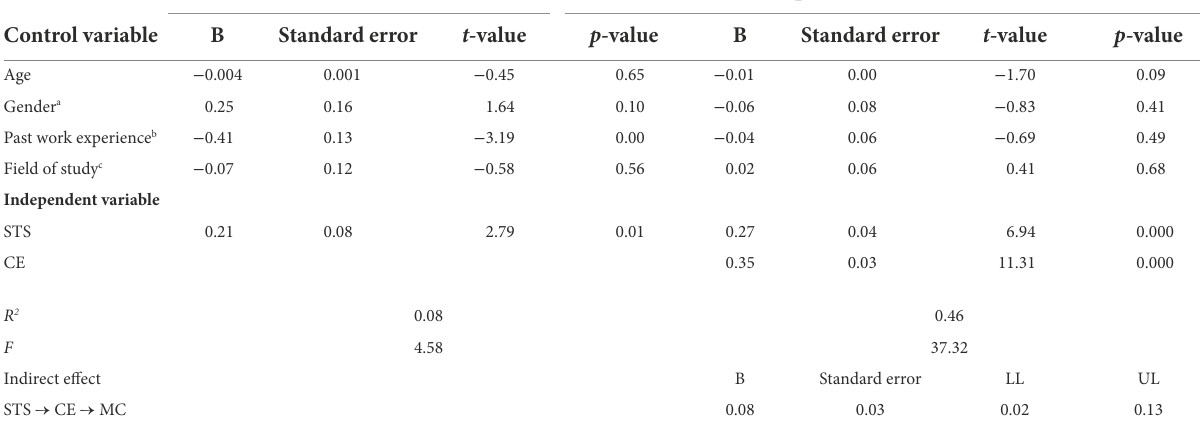
TABLE 3 Summary of the Mediation Analysis (Hypothesis